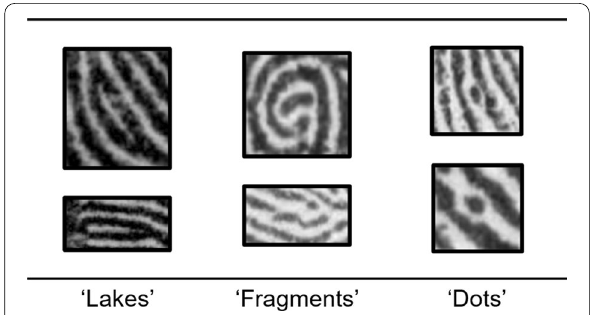
Fig. 2 Examples of rare minutiae in the fingerprint comparison